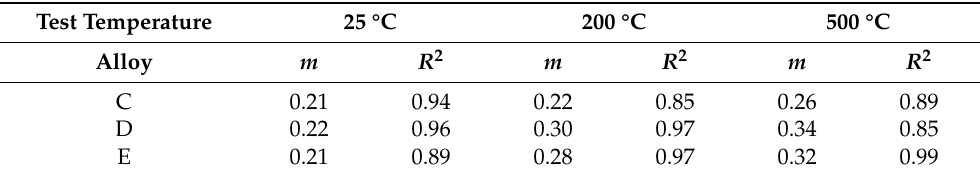
Table 4. Correlation coefficient ( R 2 ) of the log-log plots of true stress and strain rate, and strain rate sensitivity ( m ) for samples C, D and E at various test